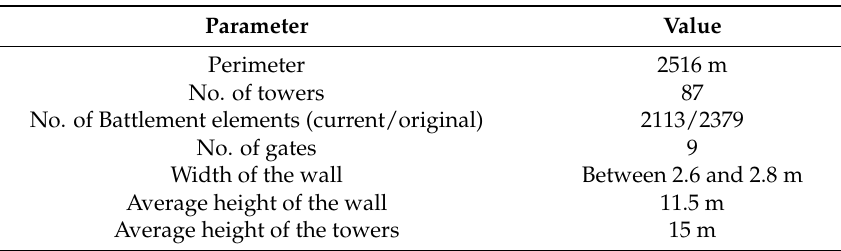
Table 3. Avila’s Medieval Wall main